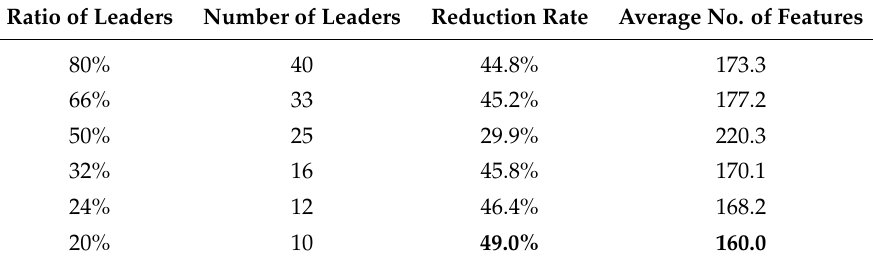
Table 2. The effect of the ratio of leaders on the reduction rate and the average number of selected